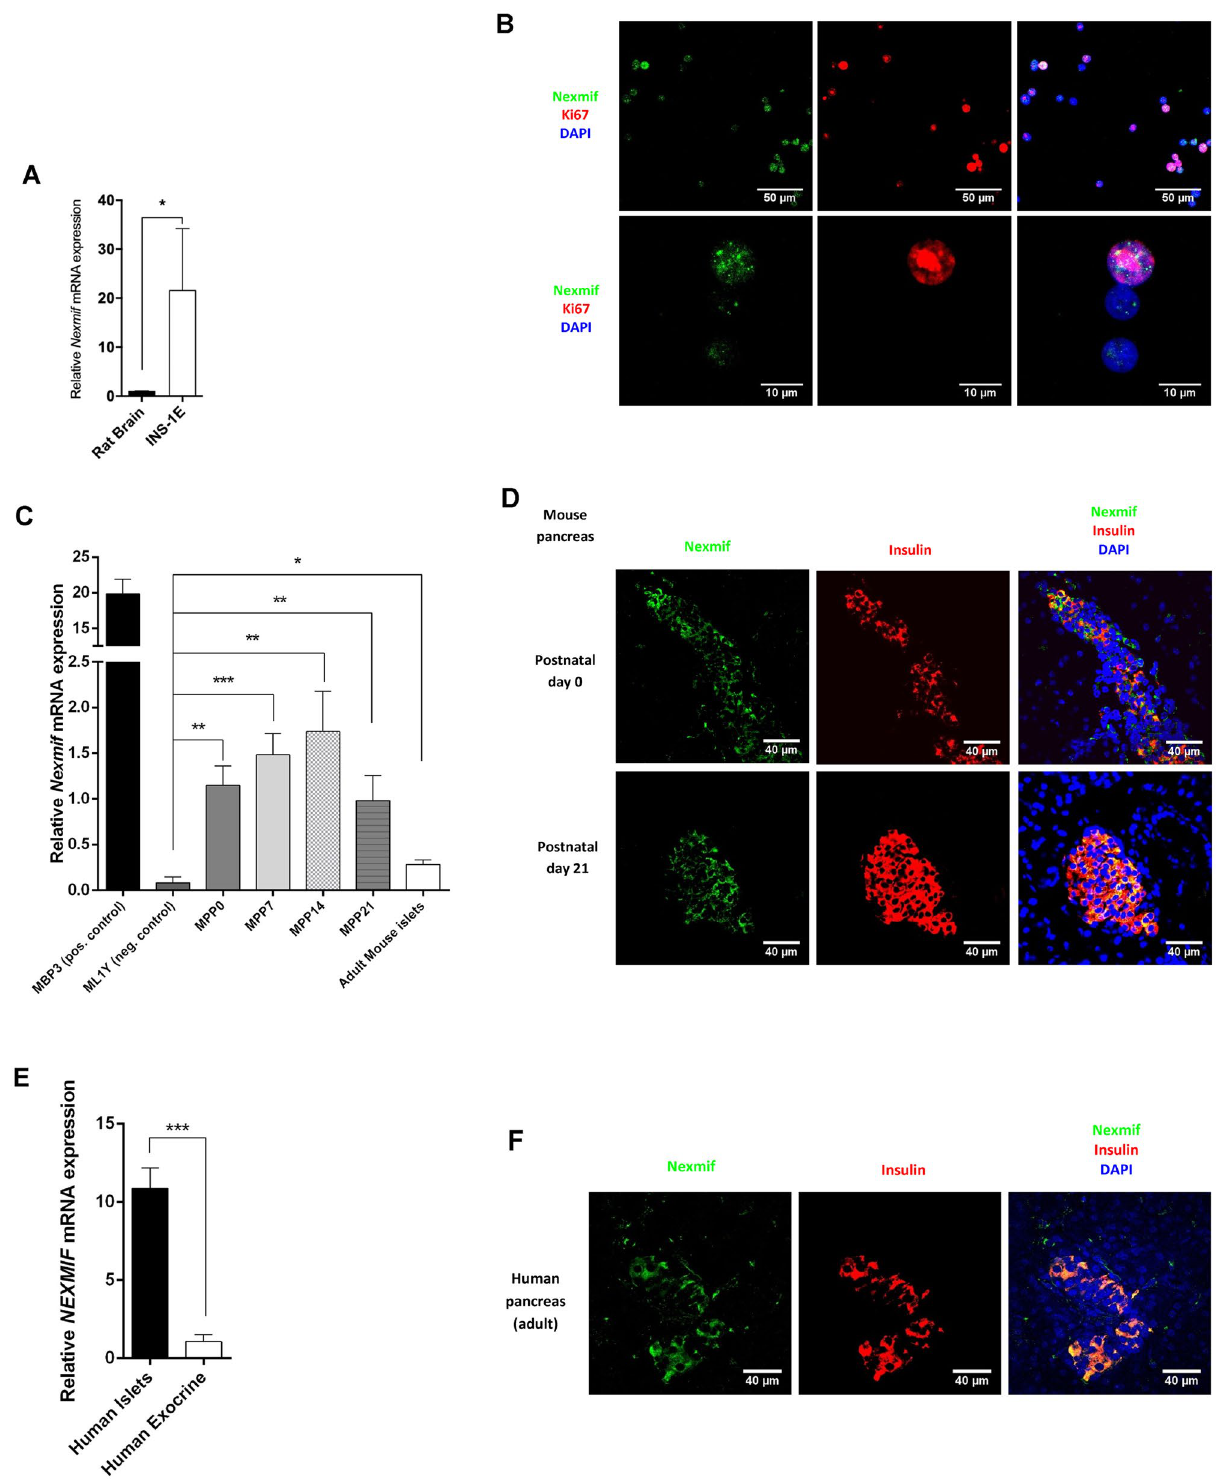
Figure 1. Nexmif expression in beta cells in different species and in INS-1E cells. ( A ) Nexmif mRNA expression in rat brain (n = 3) and in INS-1E cells (n = 3). ( B ) Nexmif localization (green) in proliferating INS-1E cells marked by Ki67 staining (red). DAPI staining in blue. ( C ) Nexmif mRNA expression from left to right in mouse brain at postnatal day 3 (MBP3) (positive control, n = 3); mouse liver at 1 year (negative control, n = 3); mouse pancreas at postnatal day 0 (n = 3), postnatal day 7 (n = 3), postnatal day 14 (n = 3), and postnatal day 21 (n = 3); and adult mouse islets (n = 3). Error bars, standard deviation; n, sample size. ( D ) Nexmif localization (green) in mouse pancreas at postnatal days 0 and 21, partially co-staining (yellow) with insulin (red). ( E ) Nexmif mRNA expression in human pancreatic endocrine (n = 3) and exocrine tissue (n = 3). ( F ) Nexmif localization (green) in human pancreas partially co-staining (yellow) with insulin (red). Error bars, standard deviation; n, sample size. * P ≤ 0.05, ** P ≤ 0.01, and *** P ≤